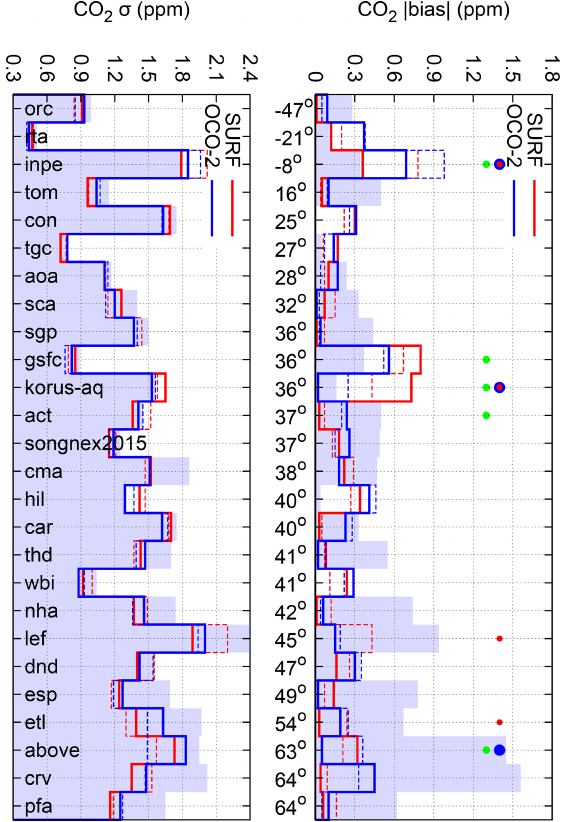
Figure 8. Same as Fig. 7 for the OCO-2 period. The number of measurements per programme varies here between 133 (CRV) and 211358